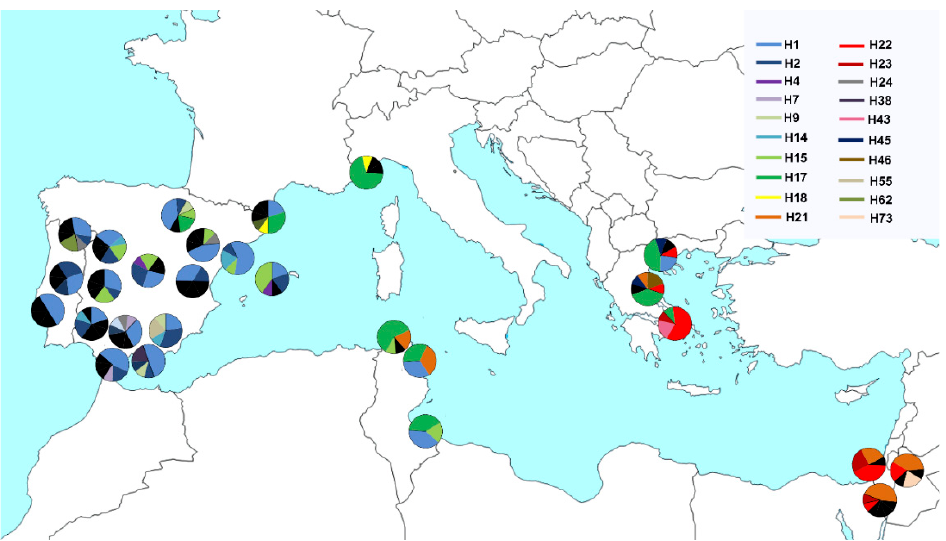
Figure 2. Pie graphs showing the distribution and relative proportion of COI haplotypes for each olive fly population sampled. Colours represent the haplotypes found. Exclusive haplotypes were denoted in black colour.